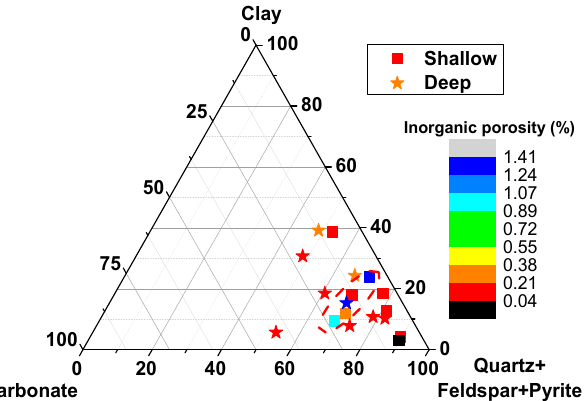
Figure 19. Relationship between inorganic porosity and mineral composition. The red dash line delineates the optimal mineral composition for large inorganic porosity.